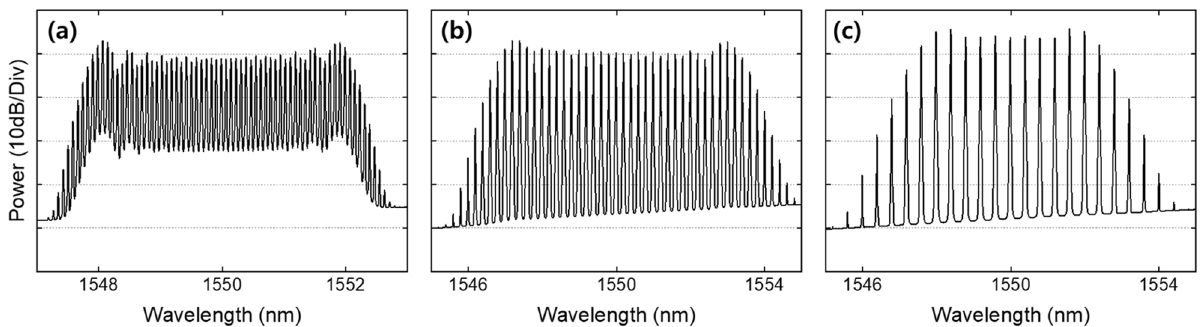
Figure 4. Experimentally measured optical spectrum of the EO-OFCs at repetition rates of ( a ) 10, ( b ) 25, and ( c ) 50